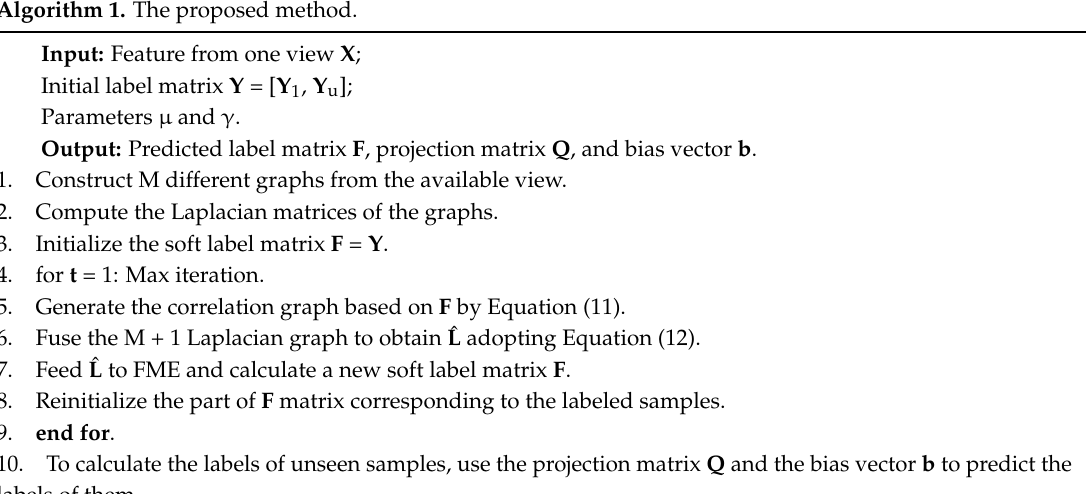
Algorithm 1. The proposed method.